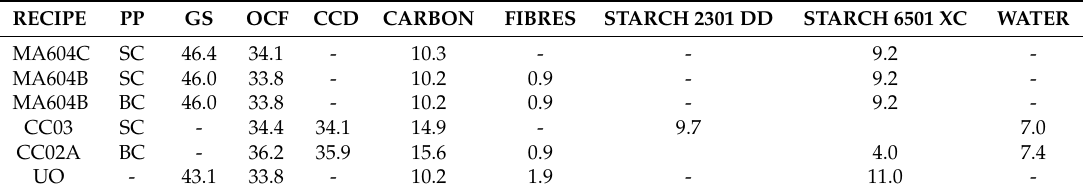
Table 12. Recipes of the agglomerates produced and tested at RWTH and UOulu (composition in wt%).